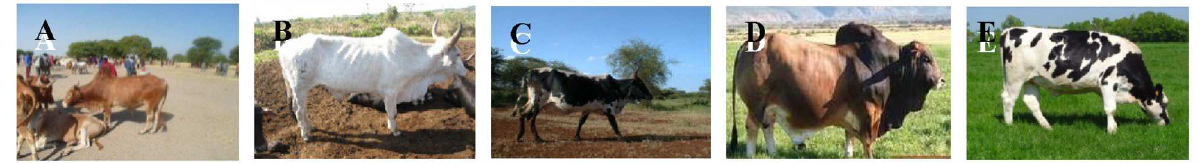
Fig 5. Photographs of individuals representing the Tanzania cattle populations and breeds involved in the present study. A: Sukuma B. Tarime C. Maasai D. Boran E. Friesian(Photo by ELKL).